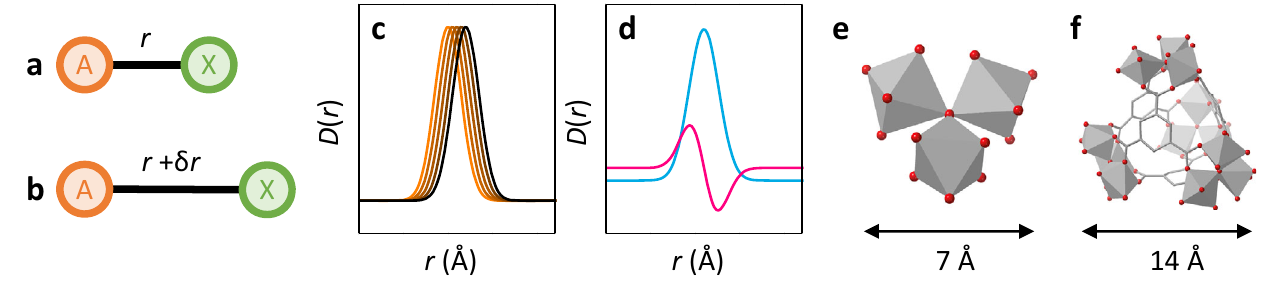
Fig. 1 Distortion components and structural chemistry. a Illustrative A – X bond of length r . b The A – X bond following a structural distortion which increases its length by δ r . c PDFs tracking the A – X bond between its original (orange) and distorted (black) state. d The fi rst (blue) and second (pink) principal components. The latter acts as a signature of the distortion that occurred to the A – X bond. The x-axis scale is the same in ( c ) and ( d ). Structure of ( e ) oxo-centred trimer unit and ( f ) tetrahedral assembly. FeO 6 octahedra (grey), O (red), C (grey) and H omitted for clarity.